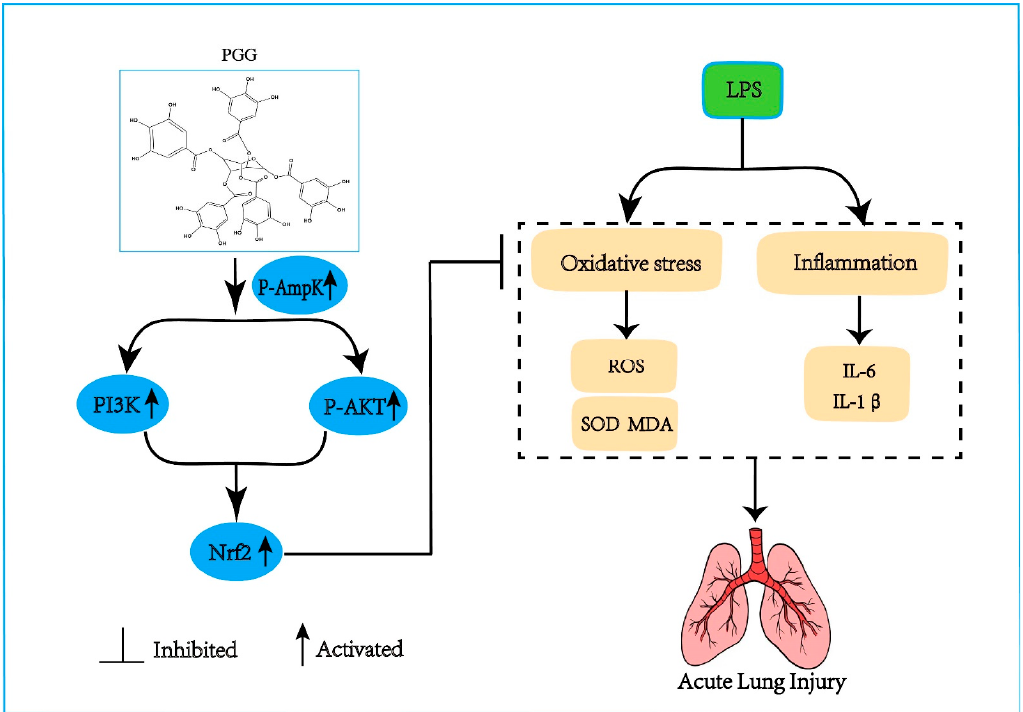
Figure 6. The effect of PGG on ALI and the underlying mechanism. The protective effect of PGG on ALI by inhibiting oxidative stress and inflammation is positively correlated with the activation of the AMPK/PI3K/Akt/Nrf2 pathway. AMPK, adenosine monophosphate-activated protein kinase; p- Akt, protein kinase B phosphorylation; IL-1 β , interleukin-1 β ; IL-6, interleukin-6; LPS, lipopolysac- charide; MDA, malondialdehyde; Nrf2, nuclear factor erythroid 2-related factor; PGG, 1,2,3,4,6-O- pentagalloylglucose; PI3K, phosphoinositide 3-kinase; ROS, reactive oxygen species; SOD, superox- ide dismutase.